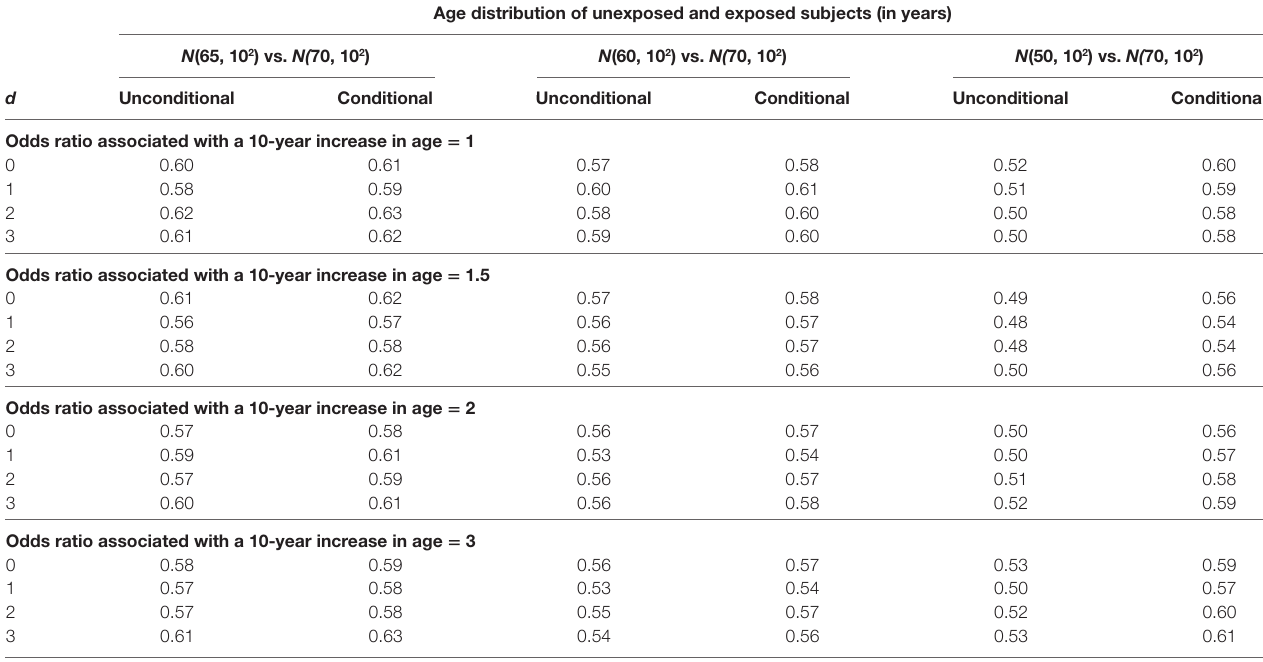
Table 6 | Widths of 95% confidence interval of unconditional and conditional logistic regression models under the alternative hypothesis. age distribution of unexposed and exposed subjects (in years)